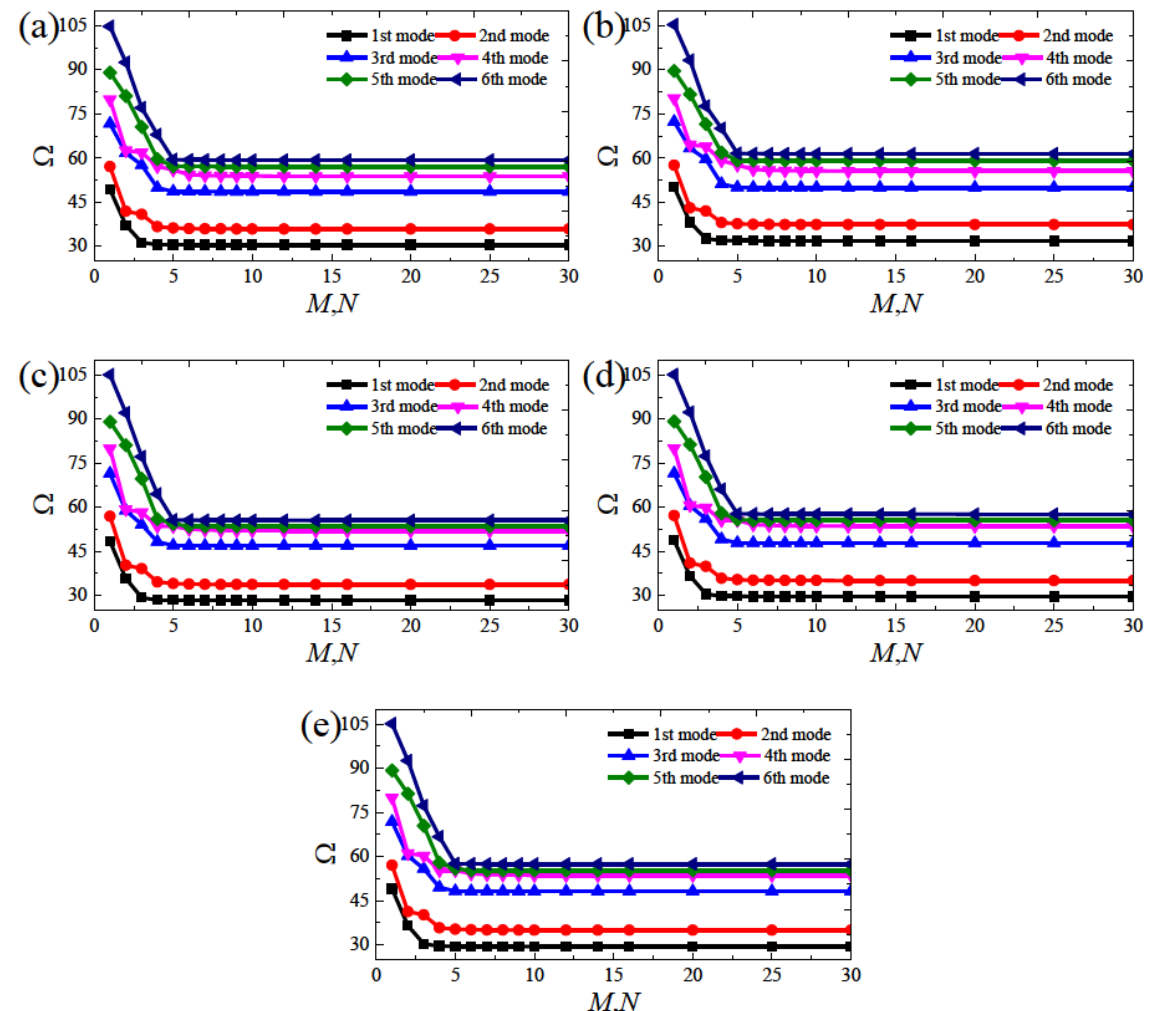
Figure 4: Convergence of frequency parameters Ω for a clamped FG-CNT reinforced composite panel with different distribution types: (a) UD-CNT; (b) FGX-CNT; (c) FGO-CNT; (d) FGV-CNT; (e) FG Λ